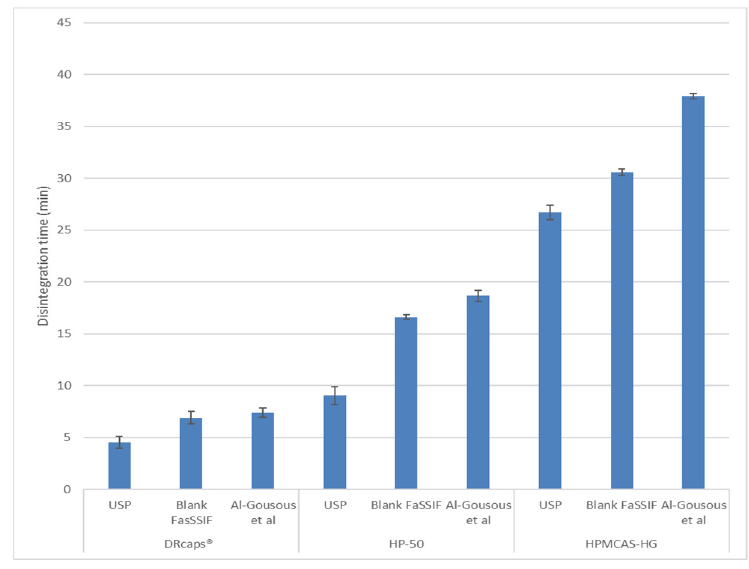
Figure 1. Disintegration times (mean ± SD) of the tested formulations (n = 6). Table 3. Weight gain (mean ± SD) of the tested formulations (n = 6) after 1 h in acidic media.